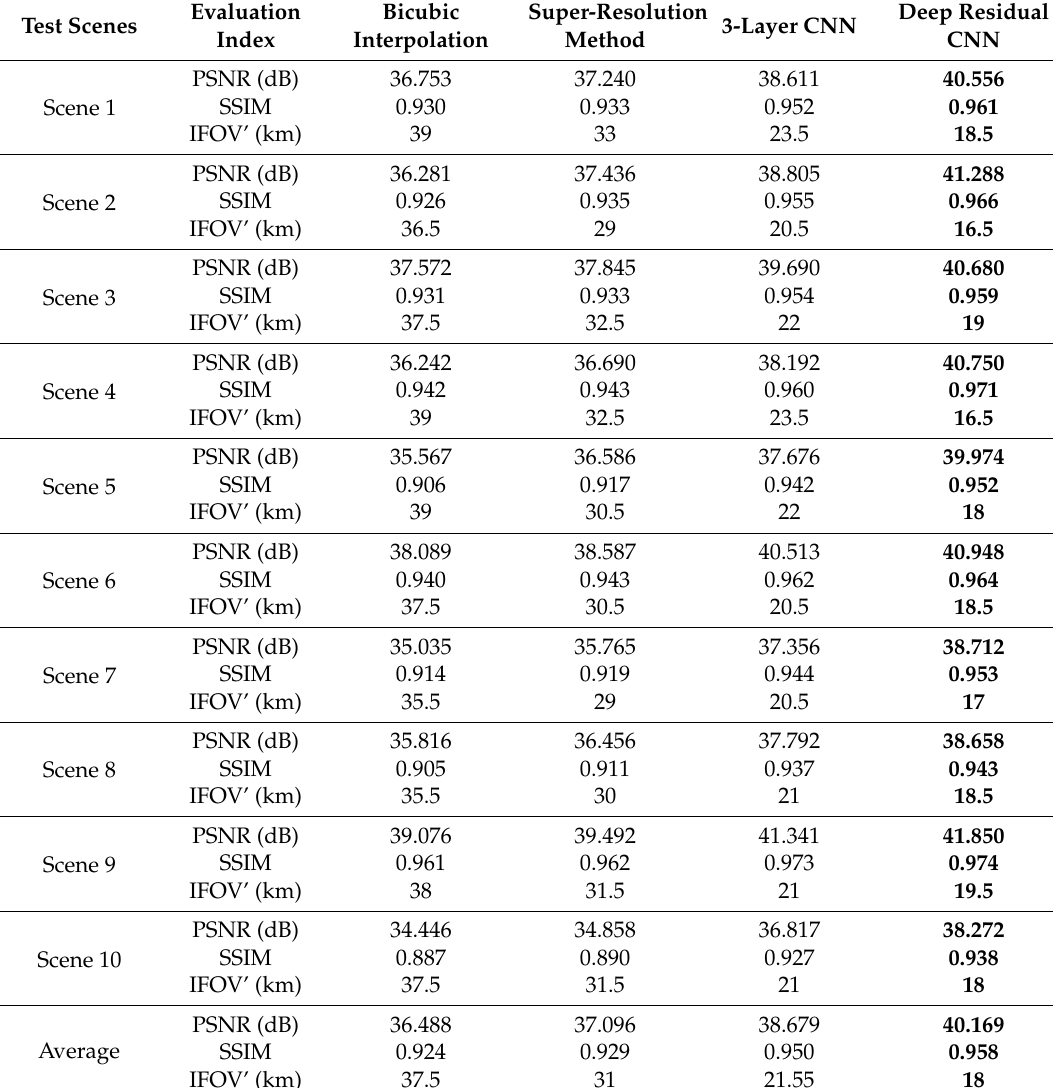
Table 2. The evaluation indexes of the 10